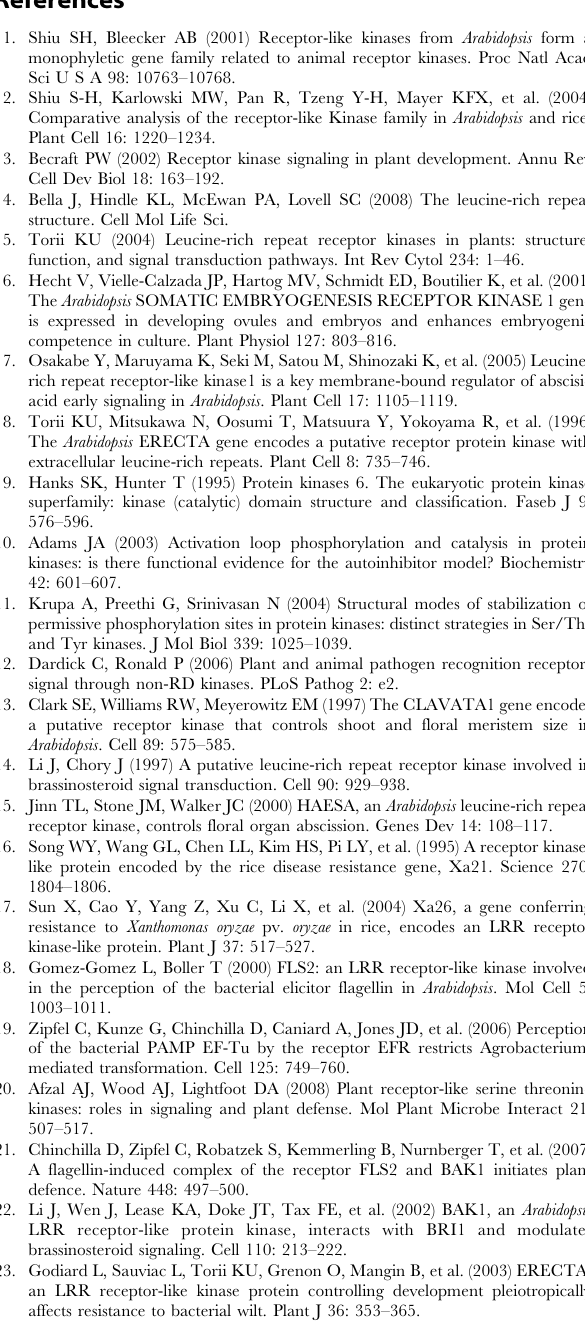
Table S1 Coding DNA and protein sequences of the 309 LKs in rice. Table S2 The accession numbers with incorrect anno- tations in RAP-DB and Refseq. Table S3 The functions of some known LKs and their orthologs in rice. Table S4 Clusters of LK genes in rice